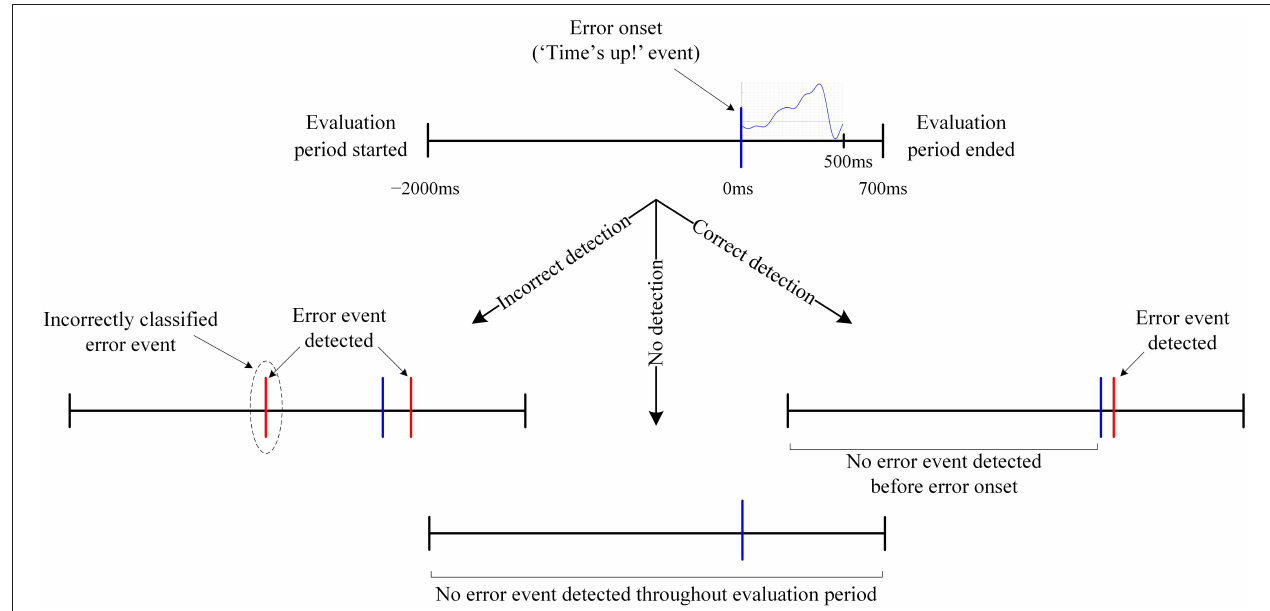
FIGURE 4 | Graphical representation of an error trial structure and the evaluation period. All occurrences that are neither labeled nor detailed inherit their description from the corresponding preceding node. Notably, in no detection, no error event was detected in the evaluation period despite the presence of an error event.